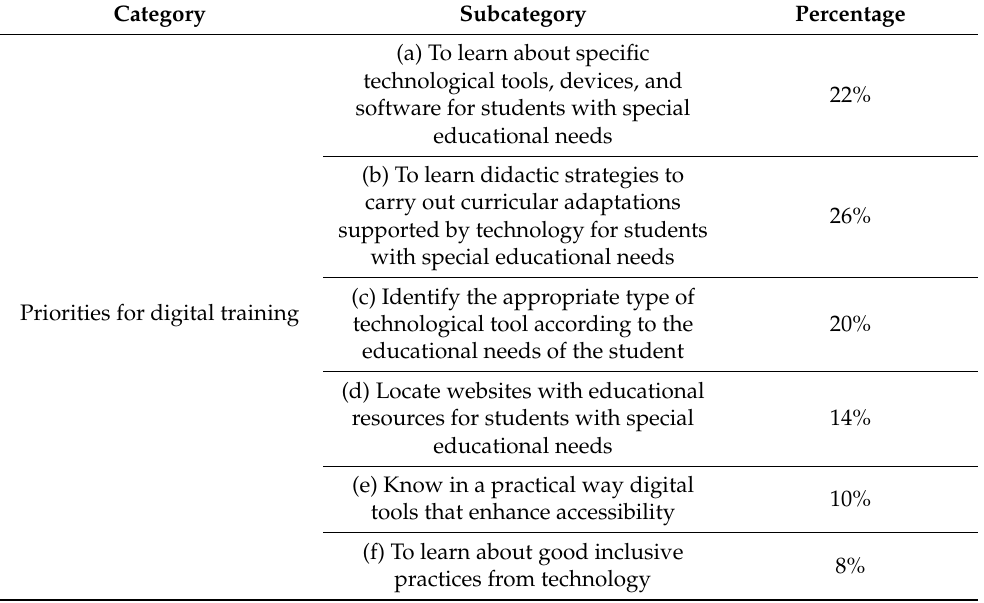
Table 6. Priorities for digital training.